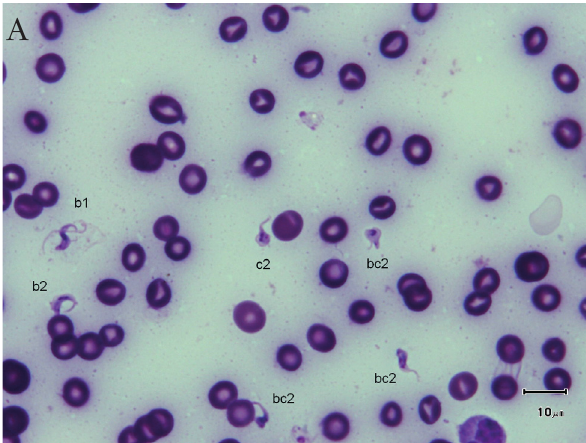
Fig. 9. – T. (Nannomonas) isomorph (b), several forms intermediary between isomorph and sphaeromorph (bc2), and some T. (Nan-